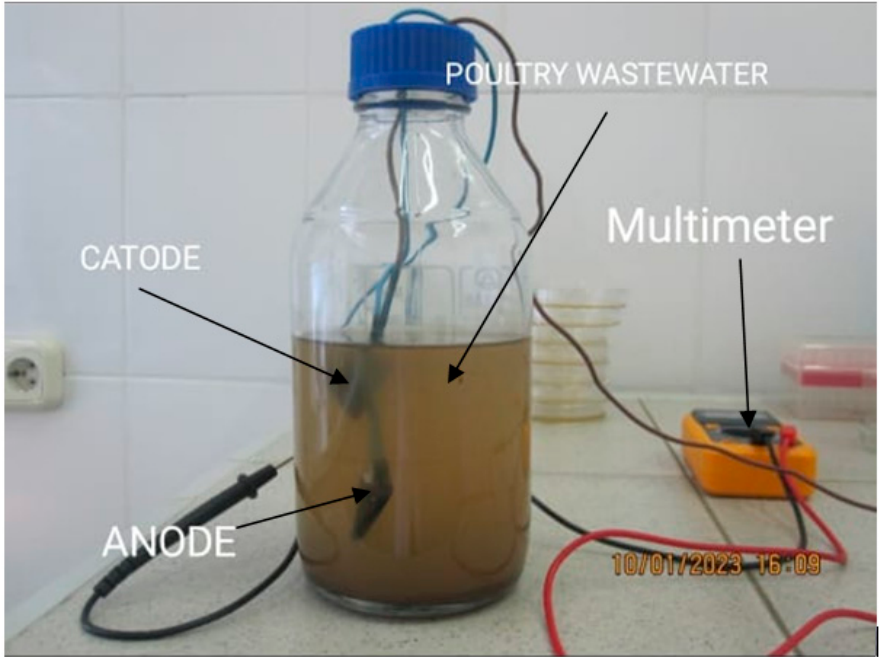
Figure 2. Single-chambered